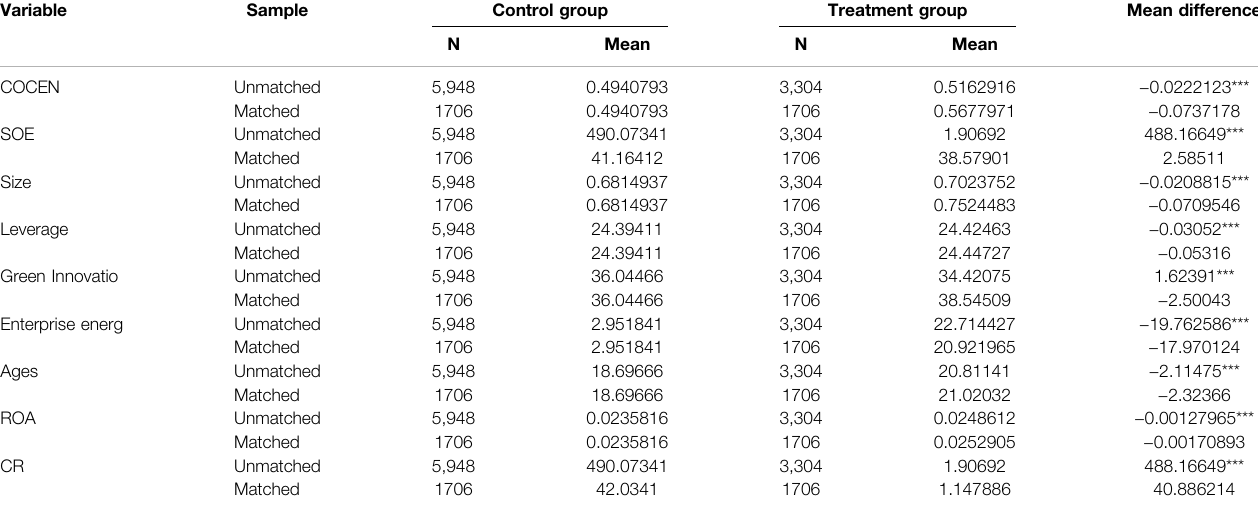
TABLE 6 | PSM balance test about